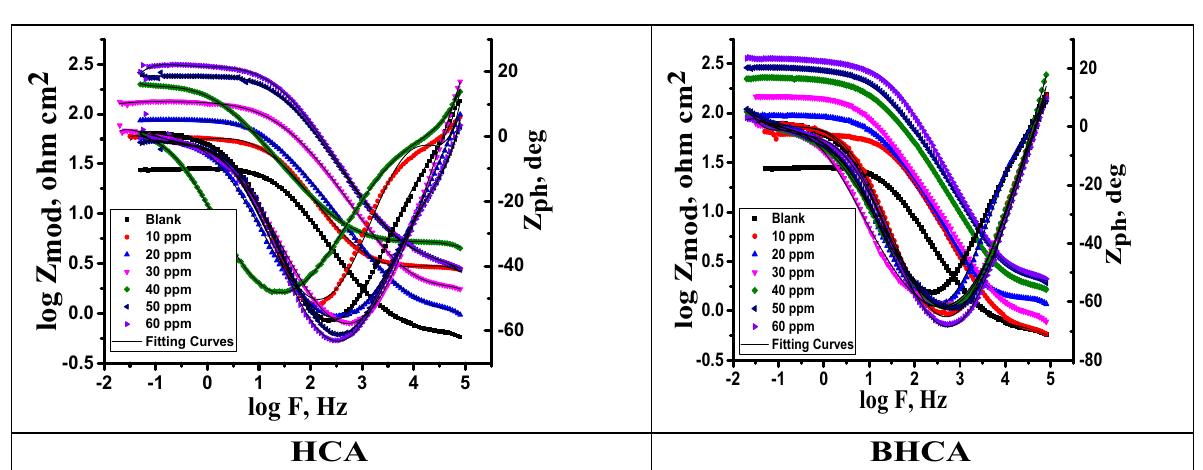
Figure 10. The Bode bends for corrosion of CS in 1 M HCl in the absence and attendance of altered doses of HCA & BHCA at 298